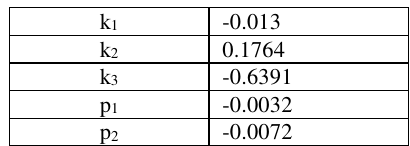
Table 4. Estimated values of intrinsic parameters .